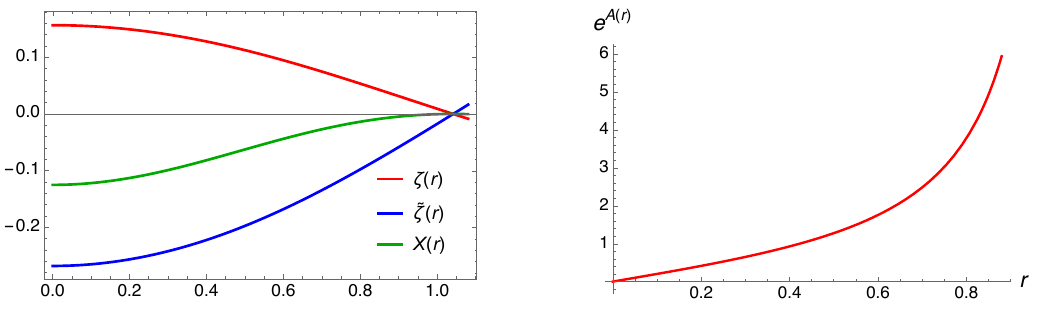
Figure 1 . Solution for x 0 = (cid:0) 0 : 125 with r UV = 1 : 041.